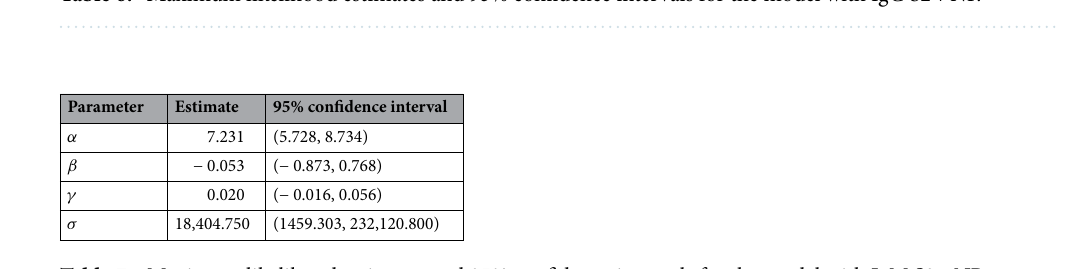
Table 7. Maximum likelihood estimates and 95% confidence intervals for the model with IgM S2 +